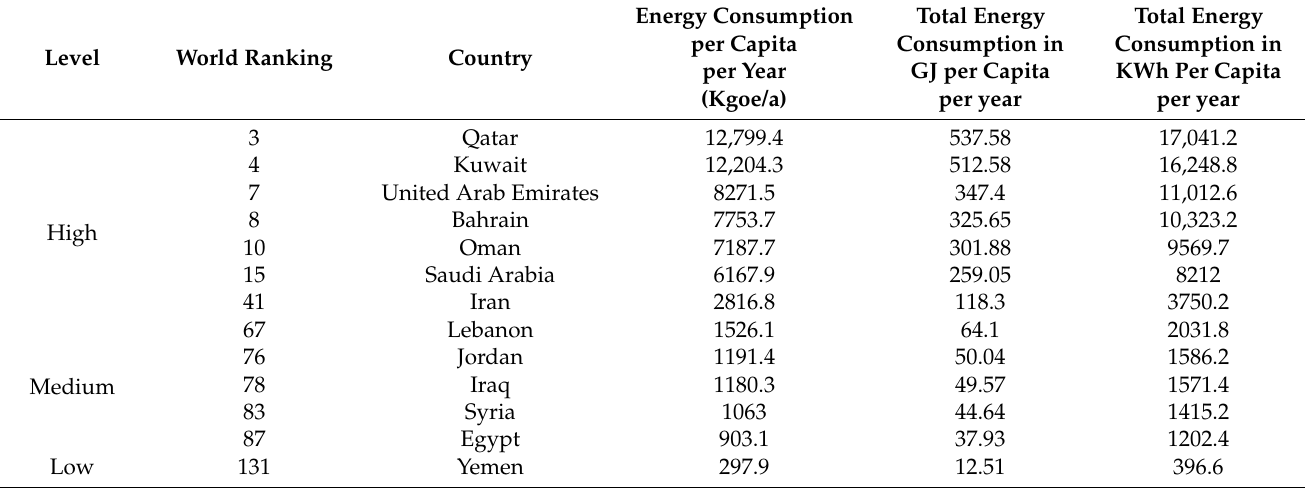
Table 1. Energy consumption per capital per country in the Middle East (Source: reproduced from the data presented by